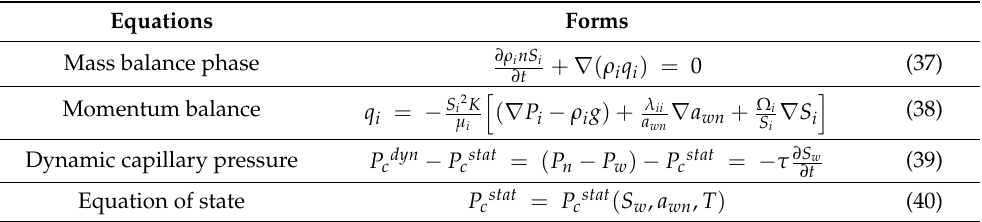
Table 5. A simplified system of advanced theory for dynamic two-phase flow in porous media [43]. Equations